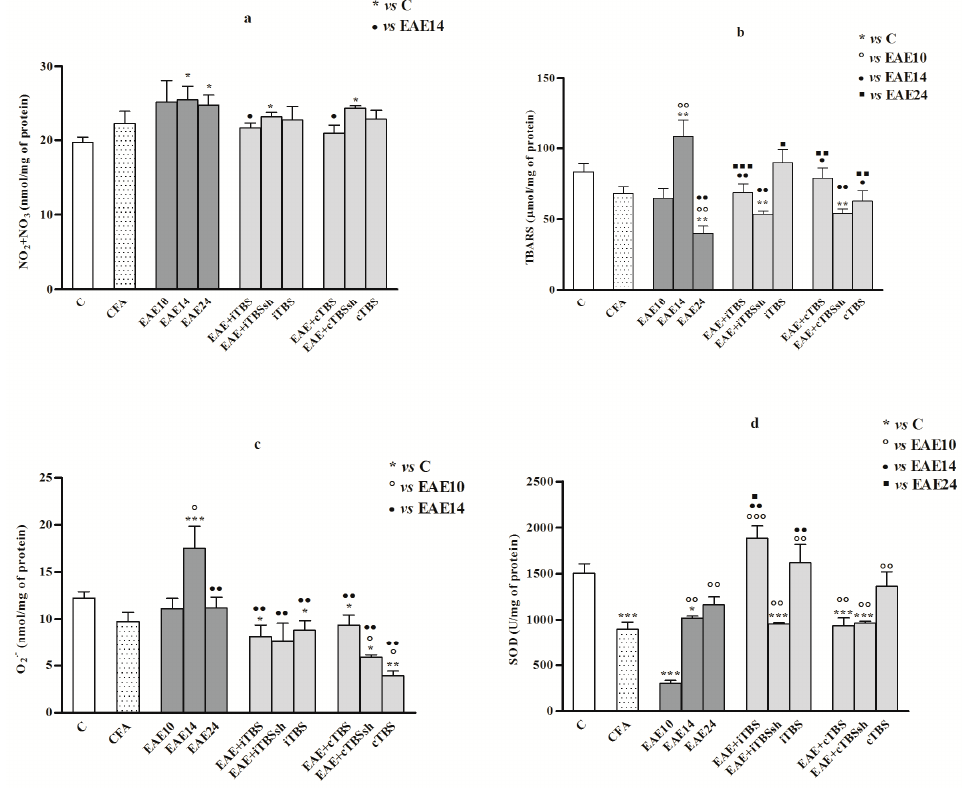
Figure 3. Reactive oxygen and nitrogen species biochemistry and lipid peroxidation status in rat spinal cord. Oxidative/nitrosative stress parameters in the spinal cord at 10, 14 and 24 dpi in EAE rats, and after iTBS/cTBS: ( a ) nitrite and nitrate (NO 2 +NO 3 ; nmol/mg proteins); ( b ) lipid peroxidation (TBARS; μ mol/mg proteins—corresponds to malondialdehyde (MDA); ( c ) superoxide anion radical (O 2- ; nmol/min/mg proteins); ( d ) superoxide dismutase (SOD; U/mg proteins). Values are presented as means ± SD. * p < 0.05, ** p < 0.01, *** p < 0.001 statistically significant difference compared to control, ◦ p < 0.05, ◦◦ p < 0.01, ◦◦◦ p < 0.001 compared to EAE10, • p < 0.05, •• p < 0.01, as compared to EAE14, (cid:4) p < 0.05, (cid:4)(cid:4) p < 0.01, (cid:4)(cid:4)(cid:4) p < 0.001 compared to